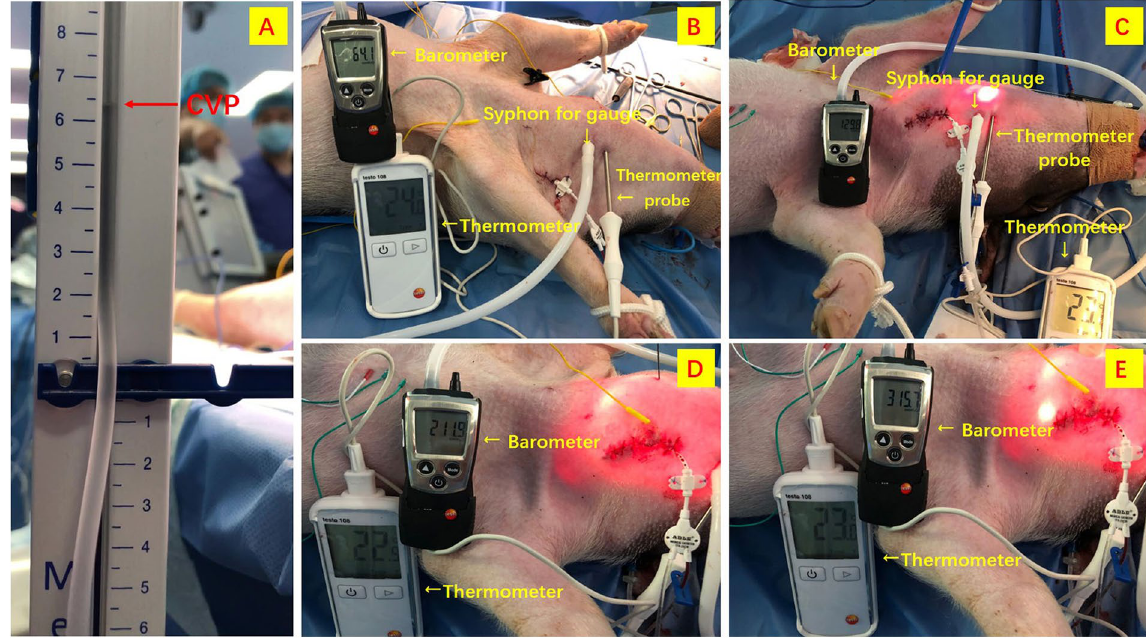
Figure 4. ( A ) Measurement of CVP. Twelve pigs were randomly divided into 4 groups according to CO 2 insufflation pressure: ( B ) 1x CVP (Group I); ( C ) 2x CVP (Group II); ( D ) 3x CVP (Group III); ( E ) 5x CVP (Group